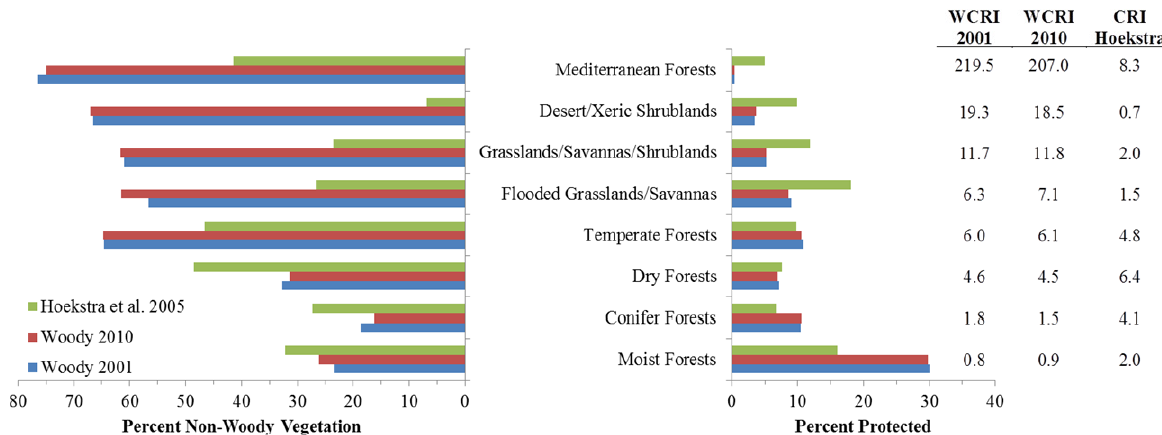
Figure 8. Biome summary of percent converted (not woody) relative to percent effective protection (protected woody) and the Woody Conservation Risk Index (WCRI = ratio of converted to protected). For comparison, Conservation Risk Index (CRI) data from [5] are included.